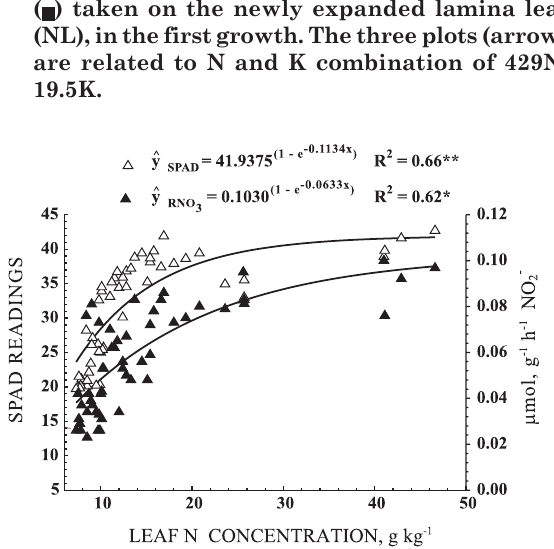
Figure 6. Relationship among SPAD readings ( ), leaf N concentration and nitrate reductase activity ( ) taken on the newly expanded lamina leaf (NL), in the second growth.